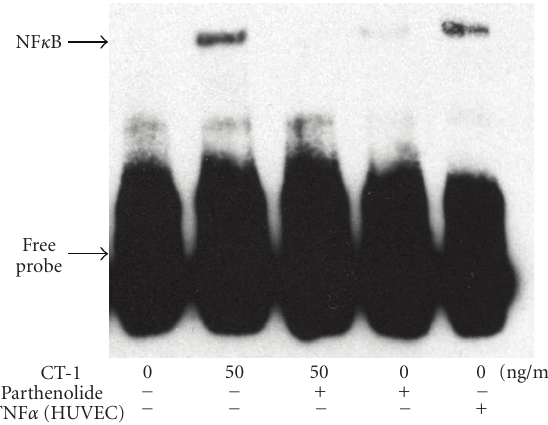
Figure 5: Detection of NF κ B activity in human PBMC. Representa- tive EMSA of CT-1 induced NF κ B activity in PBMC, which could be inhibited by parthenolide an inhibitor of NF κ B activation. Human umbilical vein endothelial cells (HUVECs) stimulated with TNF α were used as control.